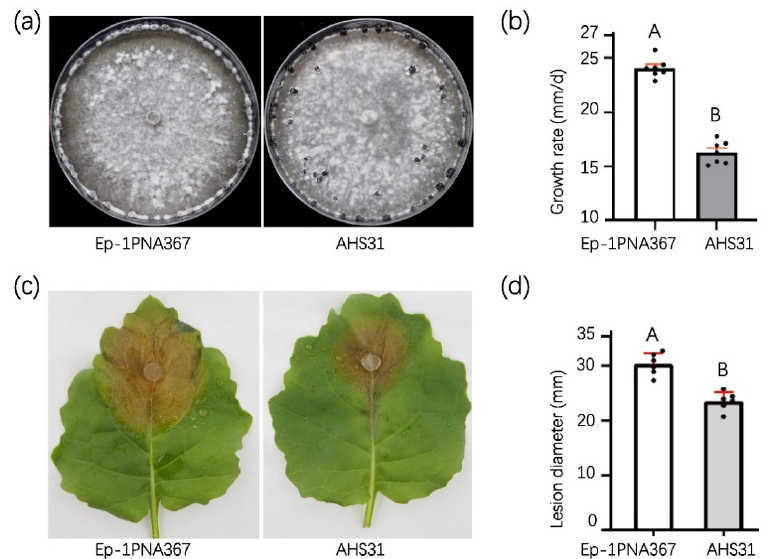
Figure 1. Biological characteristics of strains Ep ‐ 1PNA367 and AHS31. ( a ) Colony morphology of strains Ep ‐ 1PNA367 and AHS31. All the strains were cultured on PDA plates at 20 °C for 7 days. ( b ) Average growth rates of Ep ‐ 1PNA367 and AHS31 strains. ( c , d ) The pathogenicity assay of strain AHS31 (36 hpi). Error bars indicate standard deviation (SD) from sample means. Different lower ‐ case letters on the top of each column indicate significant differences ( p < 0.01).